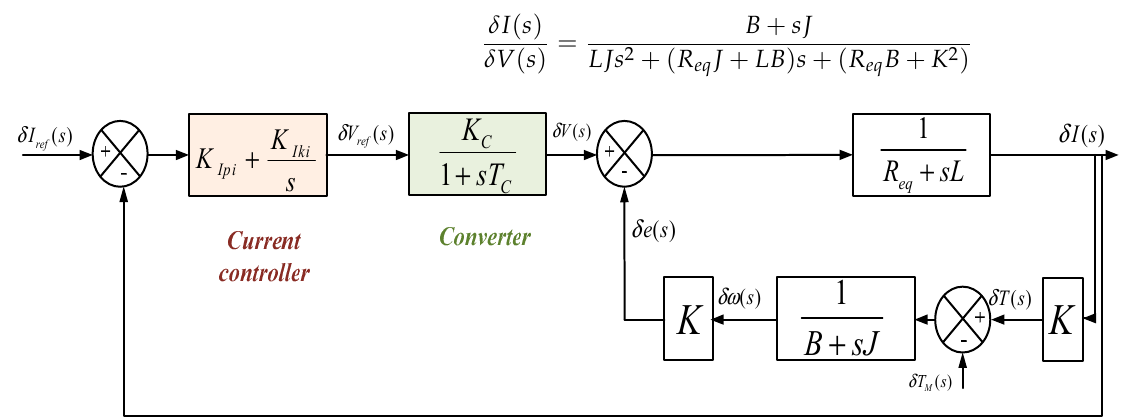
Figure 5. Schematic diagram of the linearized SRG with current control.